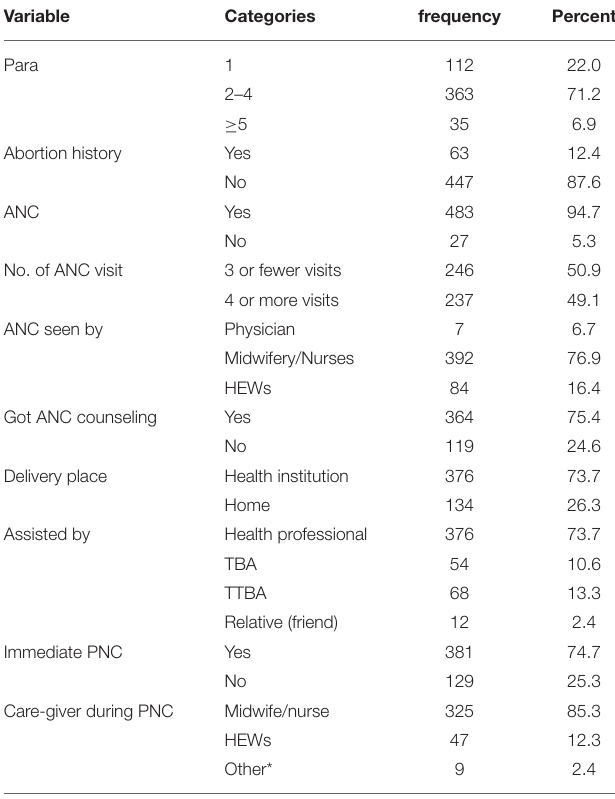
TABLE 2 | Obstetrics and reproductive health characteristics respondents in 2020 ( n =